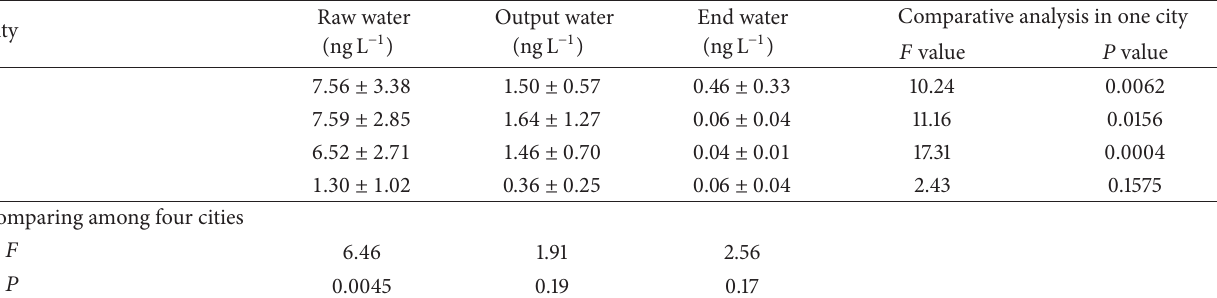
Table 2: The statistical analysis of 2-MIB levels in four cities ( 𝑛 = 60